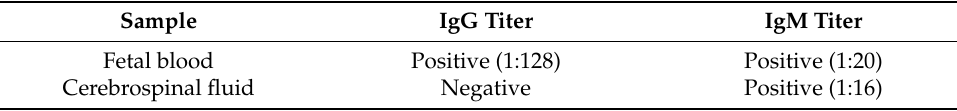
Table 1. Results of the LCMV ELISA performed in fetal